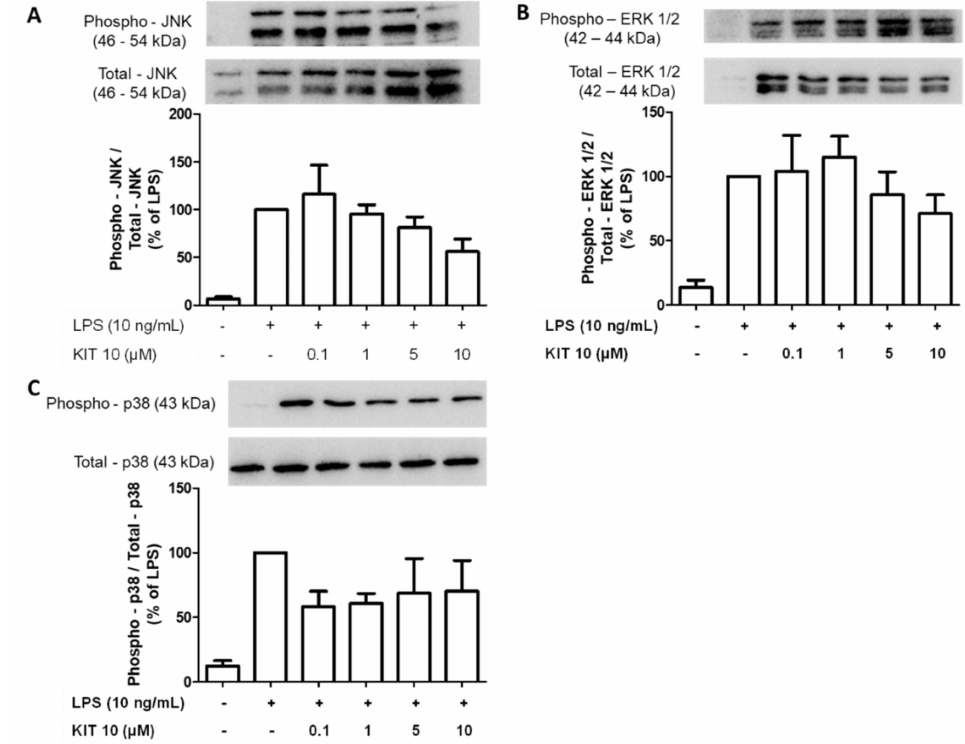
Figure 6. Effects of KIT 10 on JNK ( A ), ERK 1/2 ( B ), and p38 MAPK ( C ) in LPS-stimulated primary microglial cells. Microglia were pre-treated with KIT 10 for 30 min, afterwards, cells were incubated with or without LPS (10 ng/mL) for the next 30 min, and SDS gel electrophoresis followed by western blot performed. Representative original blots are included in Appendix A (Figure A1). Data are expressed as mean ± S.E.M. of at least three independent experiments. (One-way ANOVA followed by the Newman-Keuls